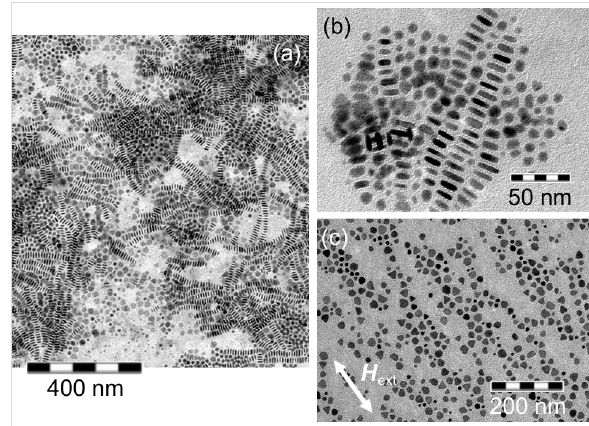
Figure 11: TEM images of self-assembled Co particles with different morphologies. Nanodisks exhibit a typical thickness to diameter ratio of 1:3 and organize mainly in rows of standing disks. Three-dimensional superstructures can be observed when two rows of disks cross each other (a). Assemblies of Co nanodisks deposited on a TEM grid (b) without and (c) under the influence of an external magnetic field of H ext = 160 kA/m applied parallel to the substrate plane.